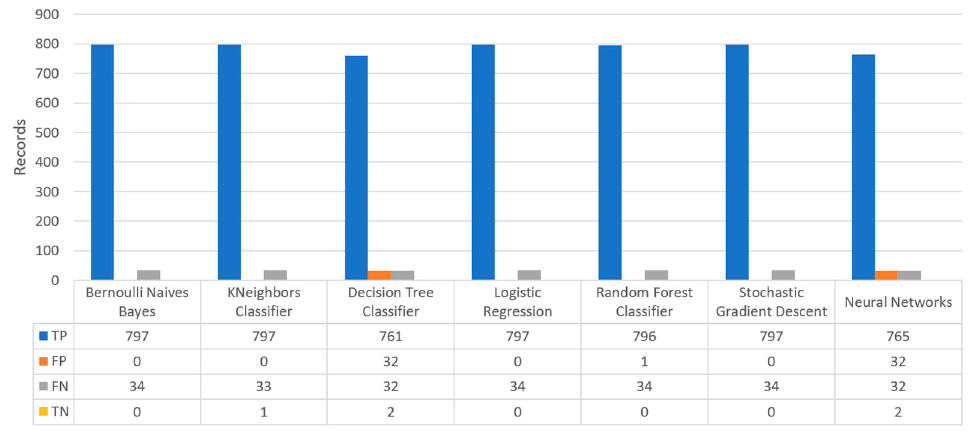
Figure 18. Train–validation–test score for stroke use case.